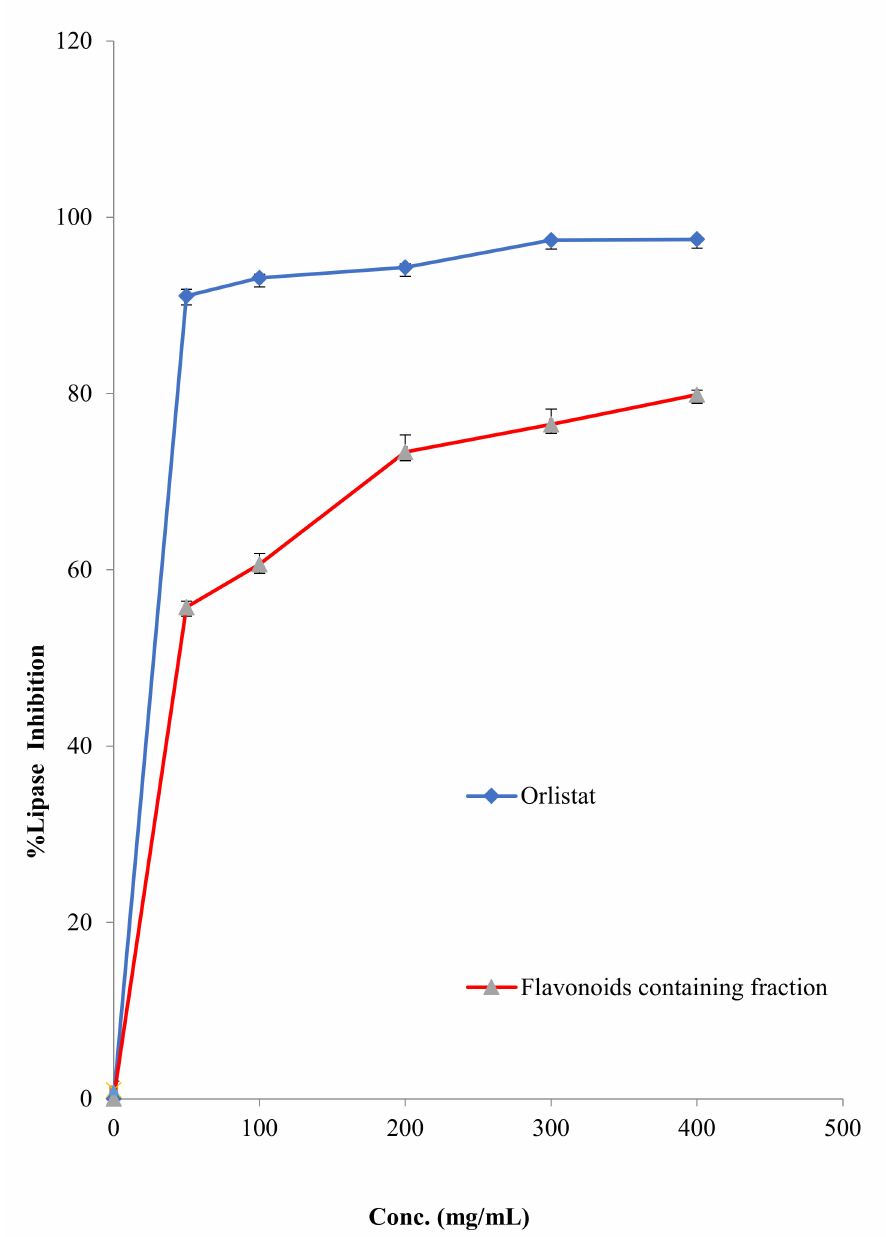
Figure 7. The lipase inhibition percentage of FFM and